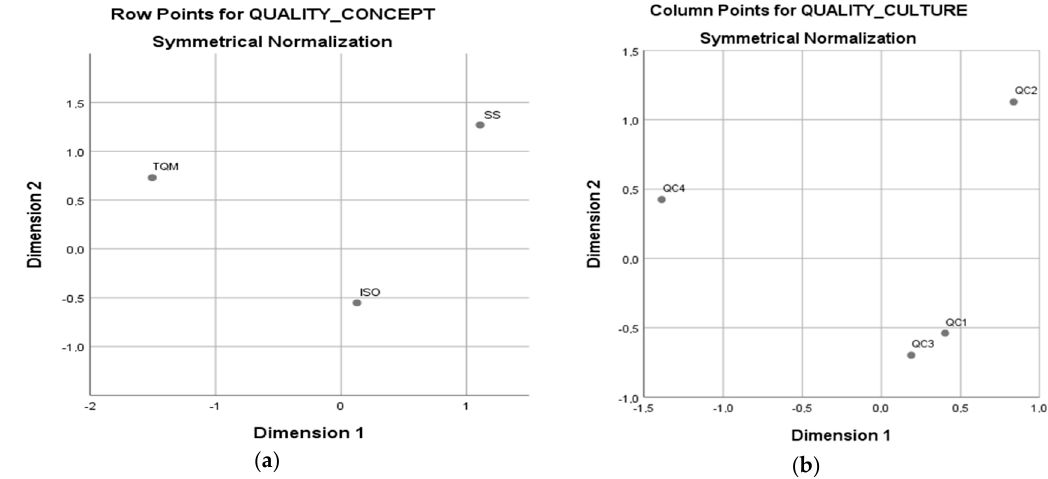
Figure 1. Correspondence maps of quality concepts (row points) and quality culture (column points). ( a ) Correspondence map of row points ( b ) Correspondence map of column points.